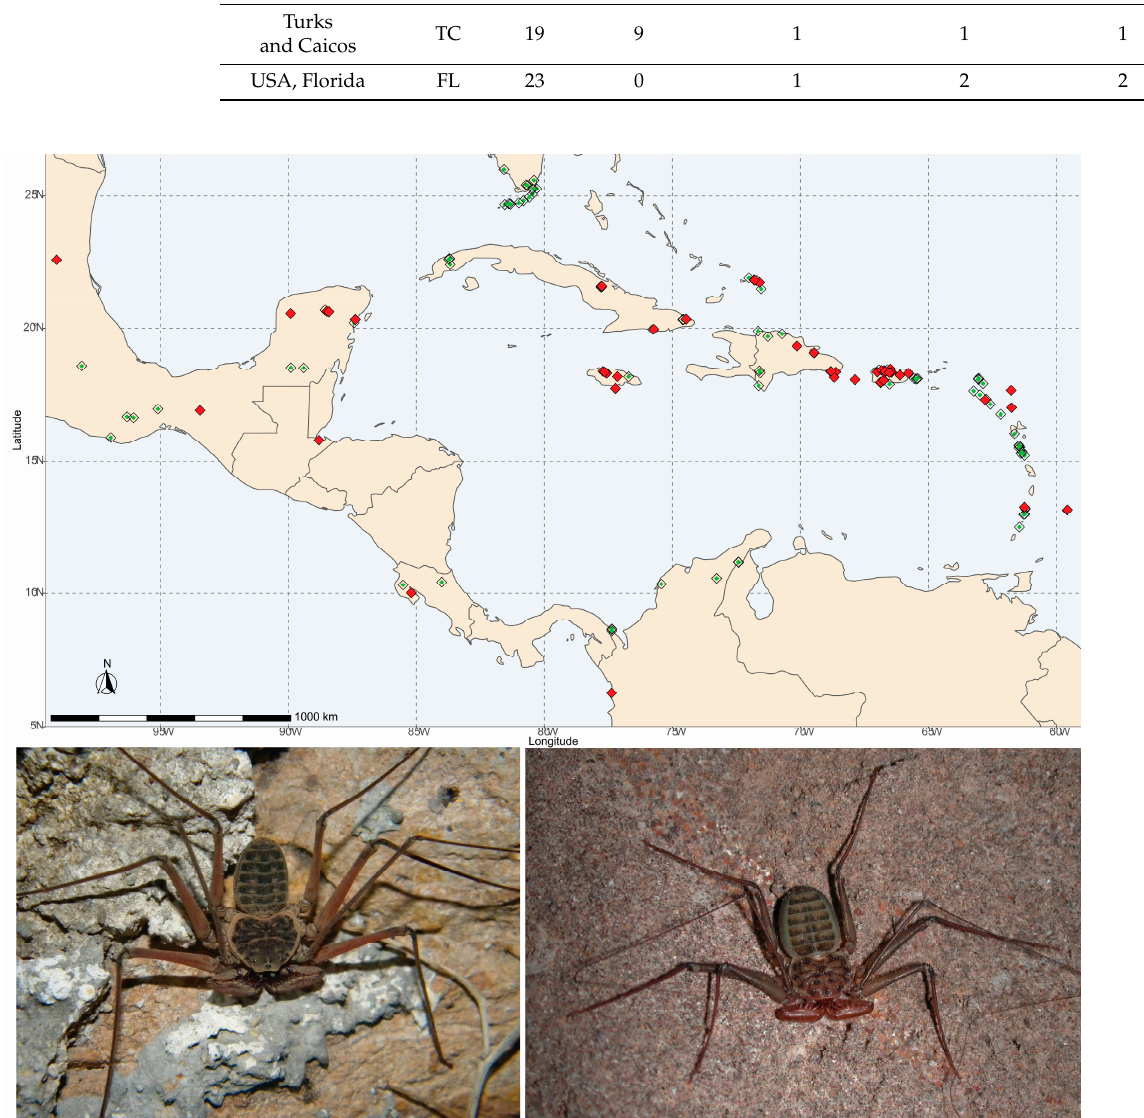
Figure 1. ( Above ) Sample sites in the Caribbean where green and red diamonds show sampling in epigean and cave habitats, respectively. Thicker lines around diamonds indicate multiple nearby collection localities. ( Below ) Photographs of P. longipes (( left ), By Maximilian Paradiz from Amsterdam, Netherlands– Phrynus , CC BY 2.0, https://commons.wikimedia.org/w/index.php?curid=64070641 and Paraphrynus Mexicanus (( right ), by Marshal Hedin from Wikipedia commons (both accessed on 15 February 2023)). Table 1. Samples, number of specimens per country ( n ), sampled from caves, and morphological, ASAP and Poisson tree processes (PTP––a phylogenetic tree-based method) species per country. *: Lesser Antilles.